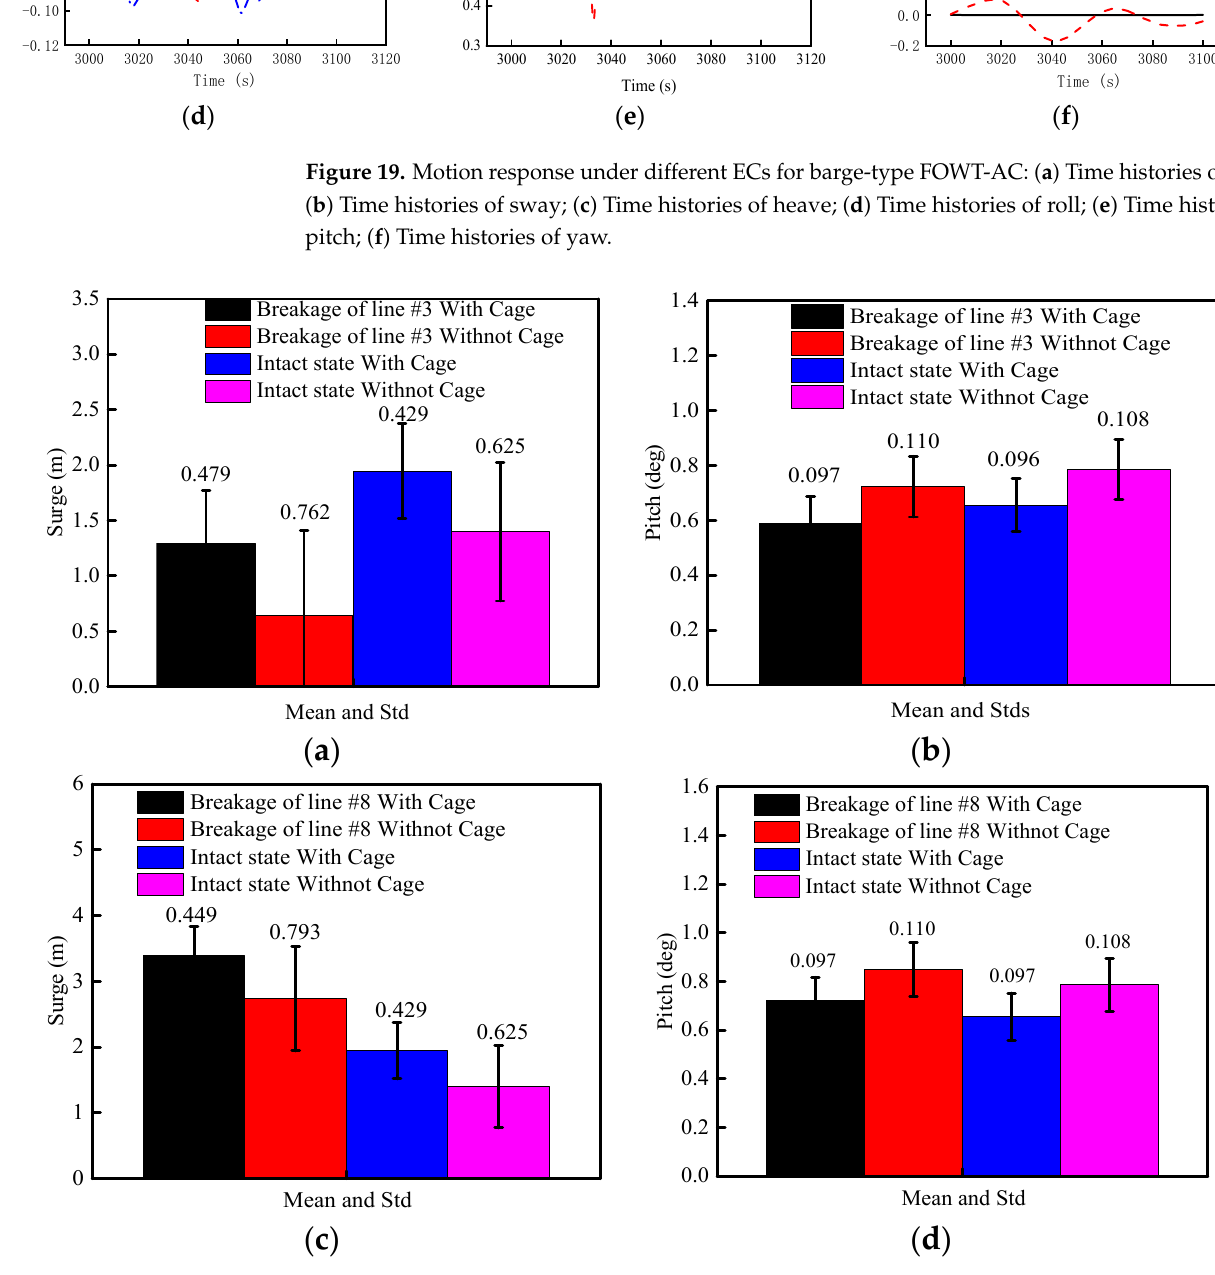
Figure 20. Comparison of motions for the barge-type FOWT-AC and barge-type FOWT under dif-